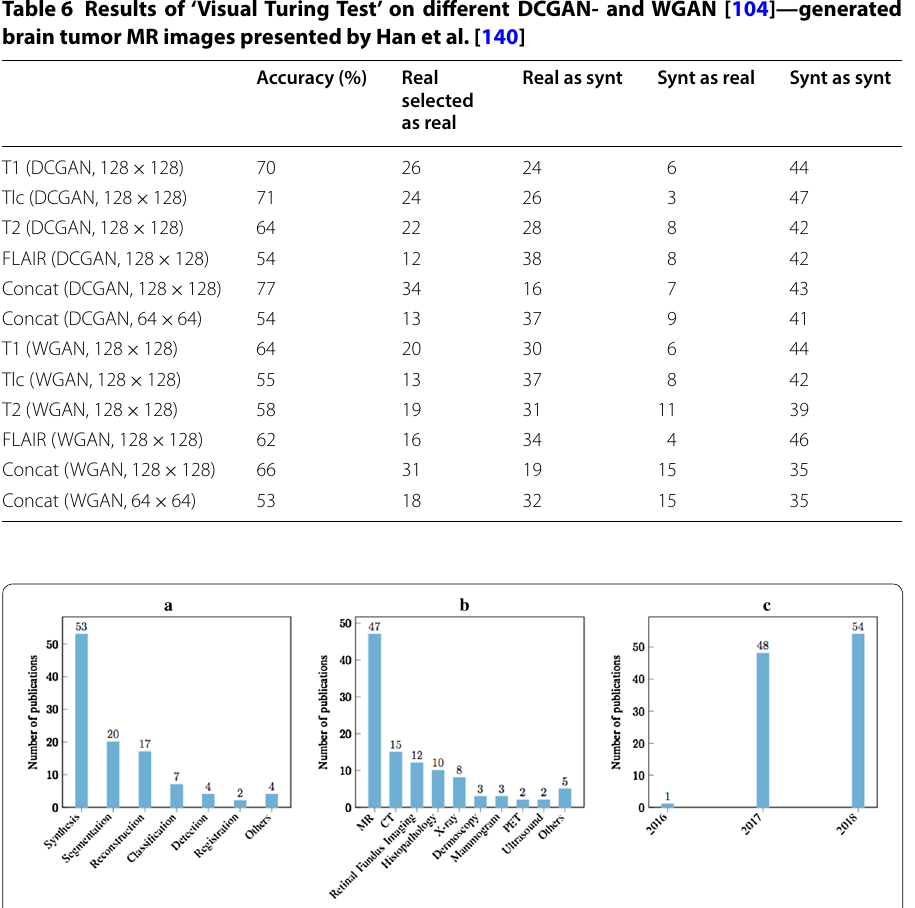
Fig. 23 Trends in applying GANs to medical image analysis